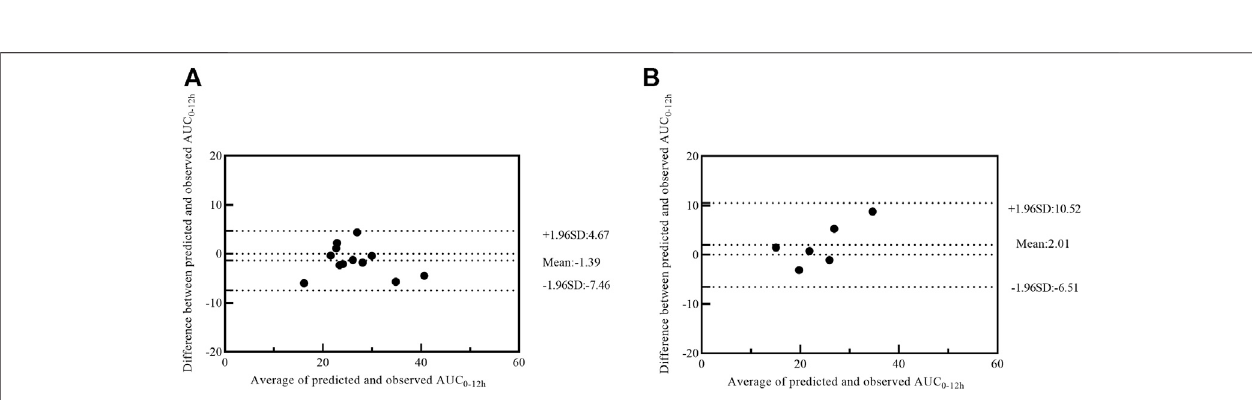
FIGURE 5| Bland – Altman plot of differences between the observed AUC 0 – 12h and the predicted AUC 0 – 12h ofMPA in model validation group (A) and MMFc group (B) by model 4. AUC 0 – 12h , the area under the 12 h concentration-time curve; MPA, mycophenolic acid; MMFc, mycophenolate mofetil capsule.